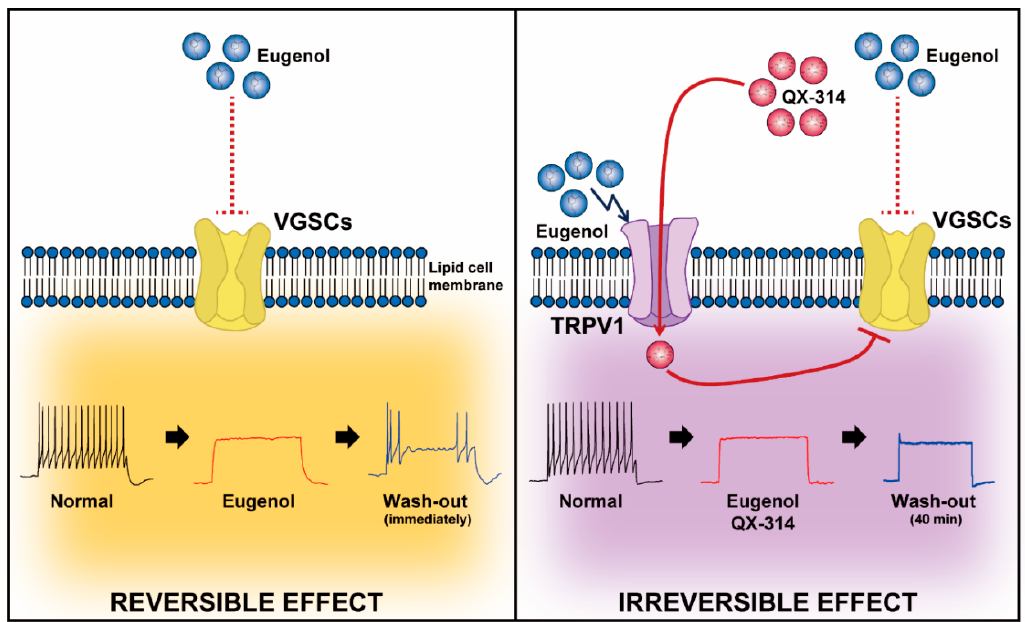
Figure 6. Comparison of reversibility between eugenol alone and co-application of eugenol and QX-314. The neuronal VGSCs and TRPV1 channels, which are the primary pain-sensing elements in pain sensation, were both expressed in sensory TG neurons. Reversible effect: The inhibition of VGSCs and AP by eugenol alone were relatively reversible after wash-out. Irreversible effect: Eugenol stimulated TRPV1 channels, then QX-314 could enter into the TG neurons via TRPV1 channels. The QX-314 suppressed the activity of VGSCs and AP, but the inhibitory effect irreversibly maintained even after wash-out.